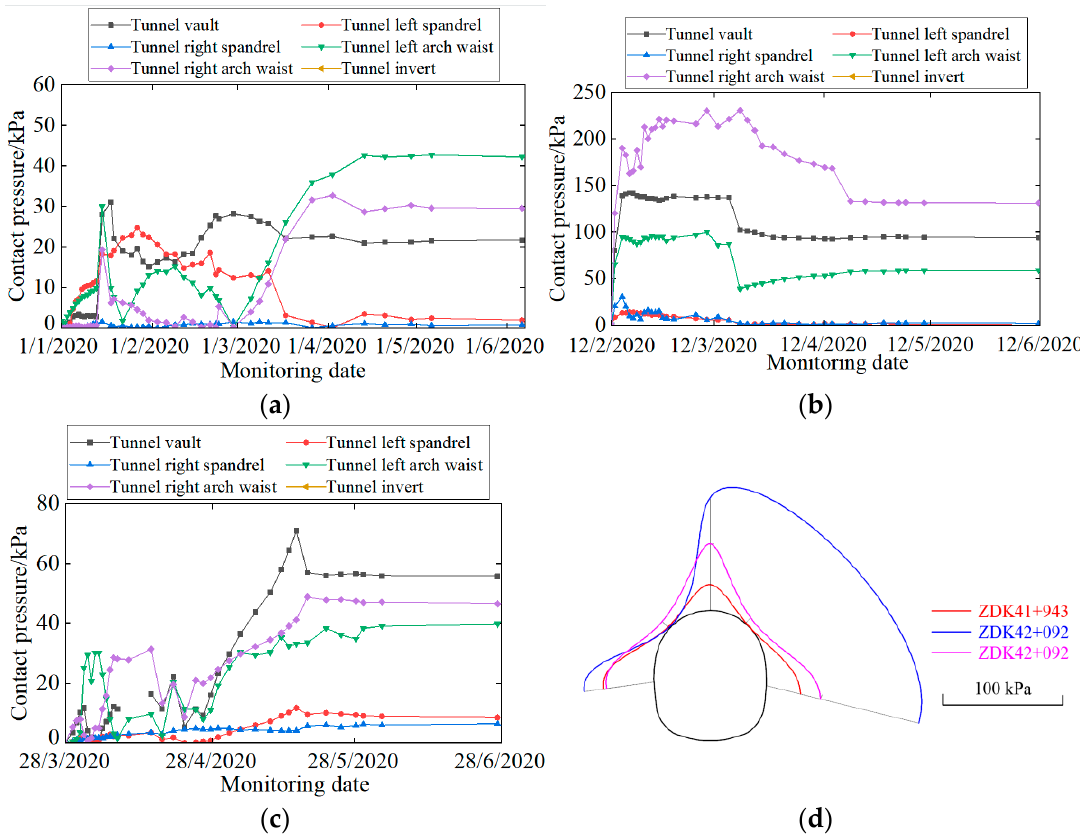
Figure 14. The contact pressure between surrounding rock and initial support: ( a ) the time ‐ history curve of the contact pressure of the monitoring section ZDK41+943; ( b ) the time ‐ history curve of the contact pressure of the monitoring section ZDK42+092; ( c ) the time ‐ history curve of the contact pressure of the monitoring section ZDK42+330; ( d ) the contact pressure distribution along the section.